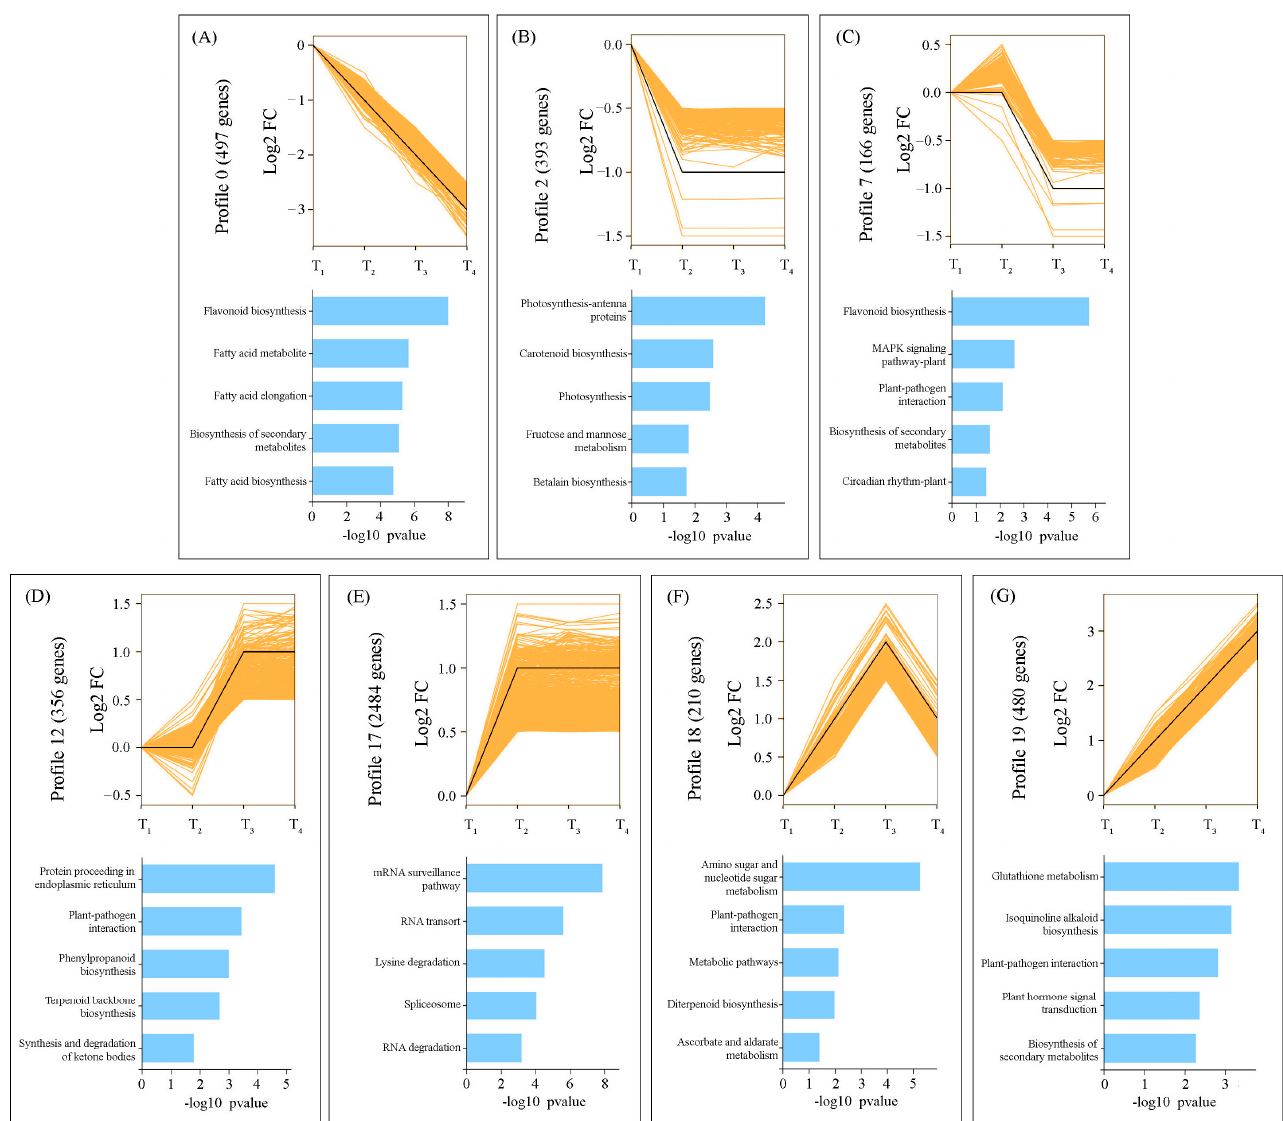
Figure 5. The dynamic expression patterns of differentially expressed genes (DEGs), which were grouped into seven significant clusters ( p < 0.05) based on the similarity of their abundance profiles ( A – G ). Below each cluster, the top five most significantly enriched KEGG pathways are graphically represented according to their adjusted p -values.